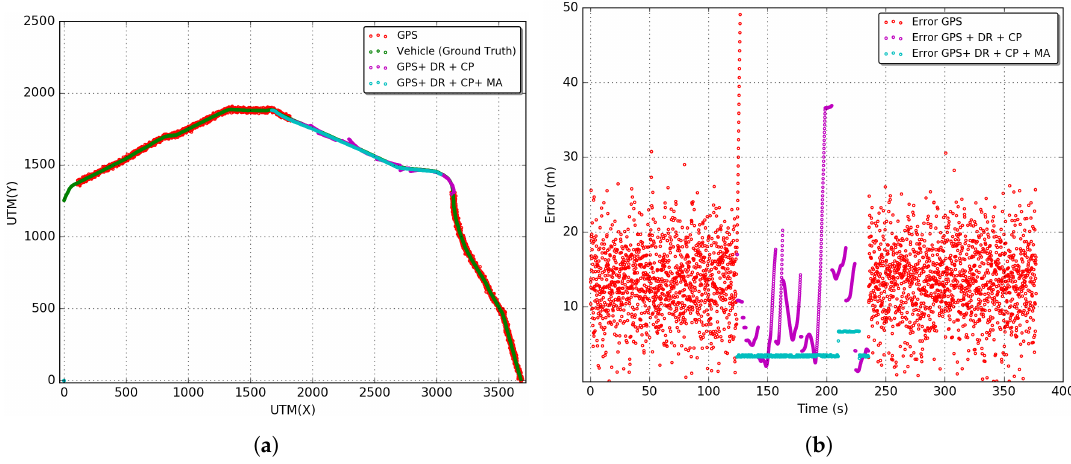
Figure 10. Estimated vehicle positioning and error over time: Rio 450 Tunnel (RIO450). ( a ) Estimated vehicle position; ( b ) positioning error over time.